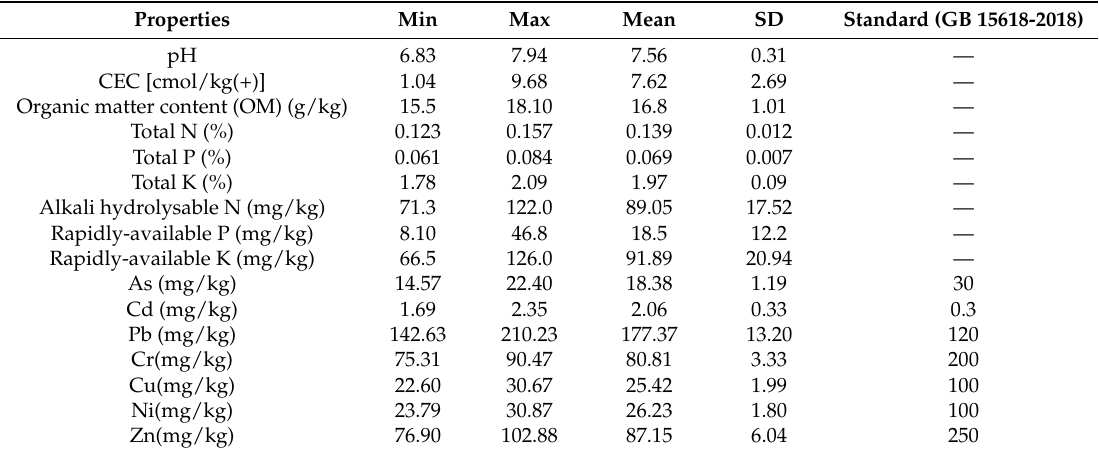
Table 1. Physicochemical characteristics of the soils in the field experiment site.